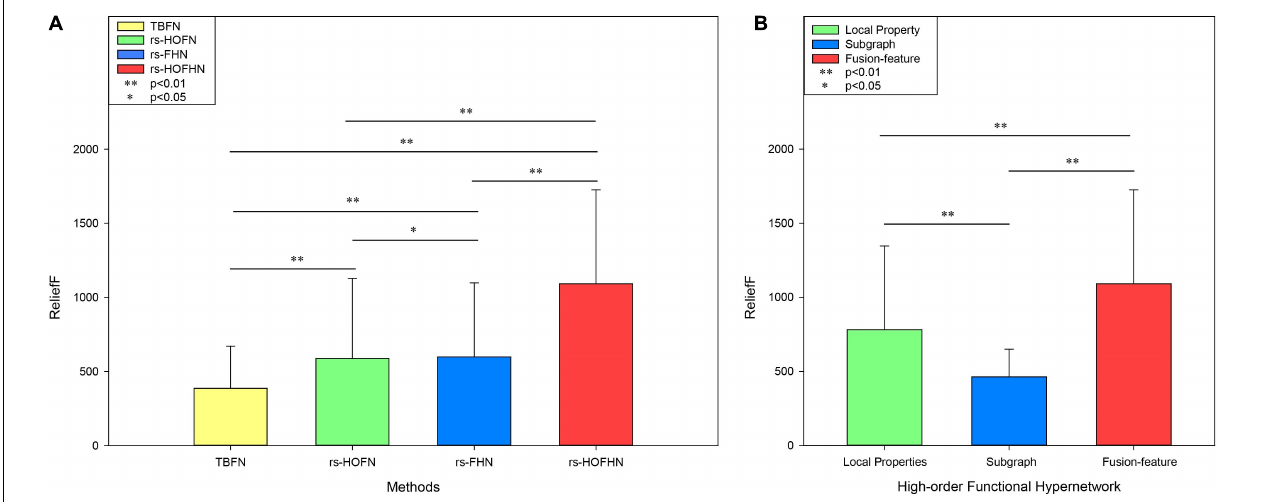
FIGURE 7 | ReliefF weights in different networks and different types of features. (A) ReliefF weights for different networks. The Y -axis represents the ReliefF weight and the X-axis indicates different networks. TBFN denotes the ReliefF weight of the corresponding local properties and subgraph features obtained from the traditional simple binary functional network. rs-HOFN denotes the ReliefF weight of the corresponding local properties and subgraph features obtained from the high-order functional network. rs-FHN denotes the ReliefF weight of the corresponding local brain regions and the subgraph features obtained from the functional hypernetwork. rs-HOFHN denotes the ReliefF weight of the corresponding local brain regions and subgraph features obtained from the high-order functional hypernetwork. (B) The ReliefF weight acquired by different feature extraction methods in the high-order functional hypernetwork. Local property indicates the ReliefF weight obtained by local property features. Subgraph indicates the ReliefF weight obtained by subgraph features. Fusion-feature indicates the ReliefF weight obtained by local property features and subgraph features. ∗∗ Represents the P -values obtained by non-parametric permutation tests that were < 0.05, while ∗ represents P -values obtained by the non-parametric permutation test being < 0.01.